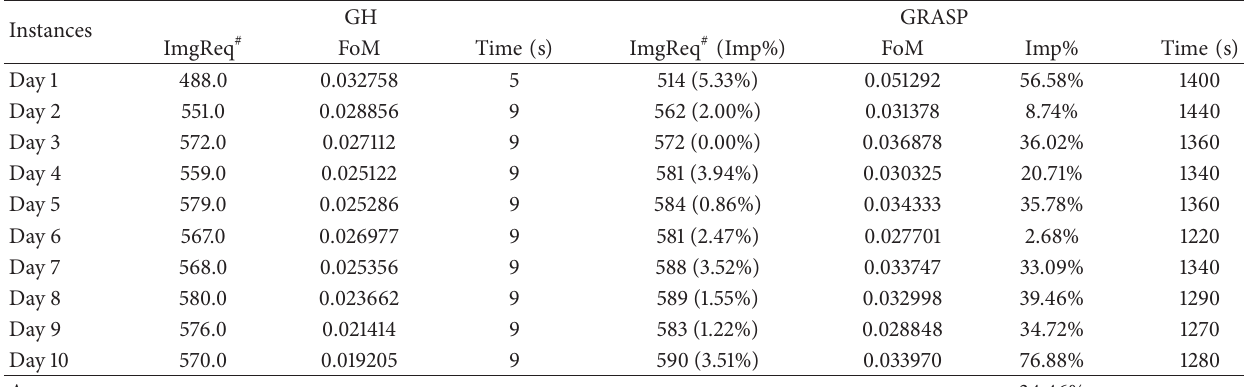
Table 1: Best results of the GH versus